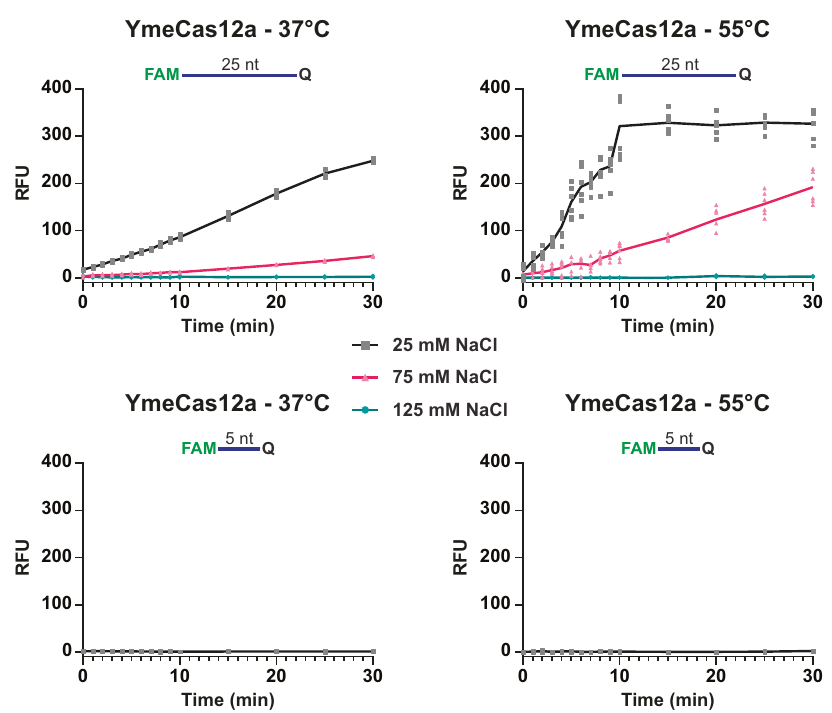
Fig. 7 YmeCas12a requires low salt and high temperature for optimal trans nuclease activity. Reactions were carried out as in Fig. 6 except that NaCl concentration was adjusted and on-target DNA cleavage plus incubation with reporter oligonucleotides was at either 37 °C or 55 °C. The mean relative fl uorescent unit (RFU) values are plotted as black (25 mM NaCl), magenta (75 mM NaCl) and blue (125 mM NaCl) lines. Reactions were carried out at all three NaCl concentrations in combination with the 25 nt reporter, but only 25 mM NaCl was used in combination with the 5 nt reporter. The RFU values represent the background normalized signal derived by subtracting the fl uorescence of negative control reactions that did not contain target DNA. Individual data points for all experimental replicates are plotted on the graphs and the source data can be found in Supplementary Data